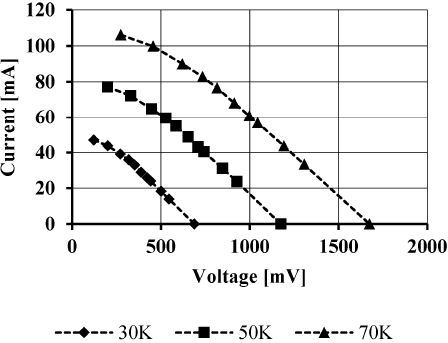
Figure 5. V - I -characteristic of a small bulk-TEG at different temperature gradients and a constant cold side temperature (0 °C).